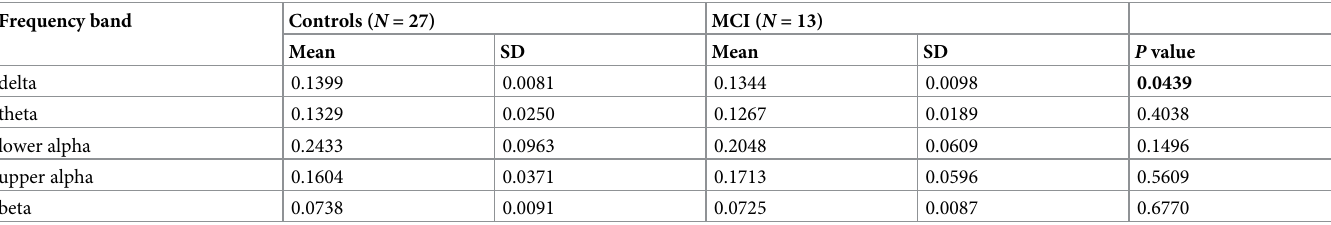
Table 3. Group descriptive for the global average PLI